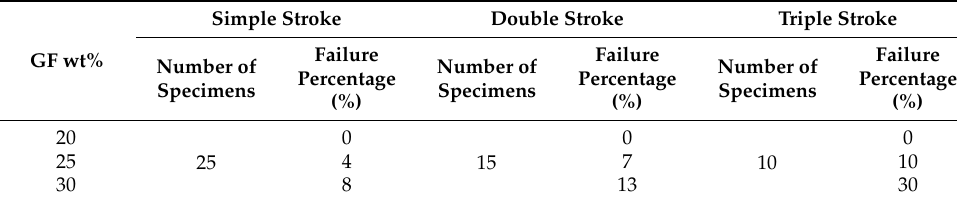
Table 3. Riveting test results as a function of GF reinforcement